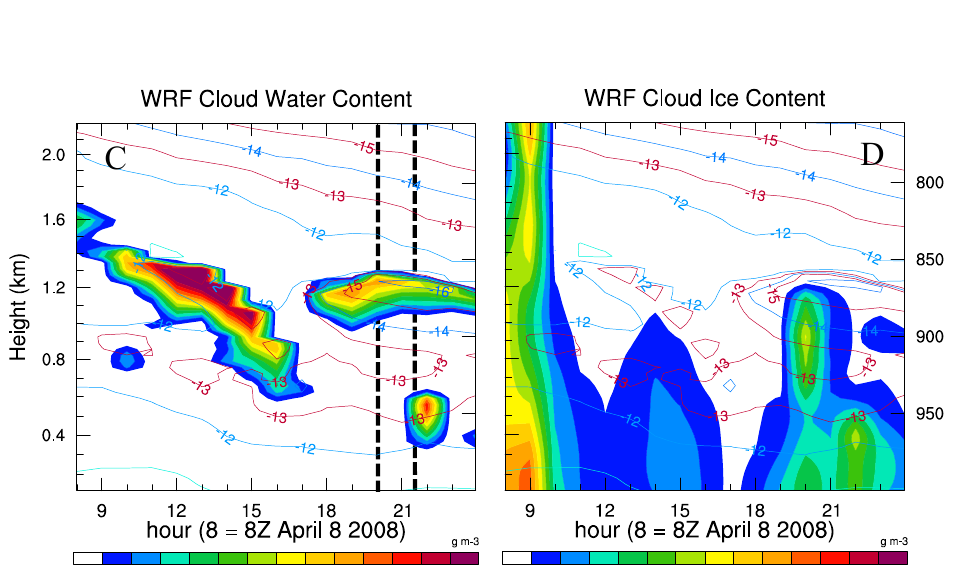
formation and boundary layer structure during this